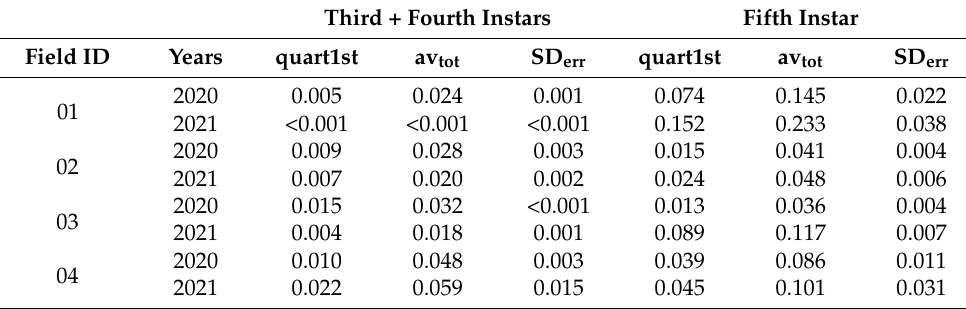
Table 5. Decrease in NDVI during 2020 and 2021 rearing seasons. Values of the decrease during the third and fourth instars and during the fifth instar are